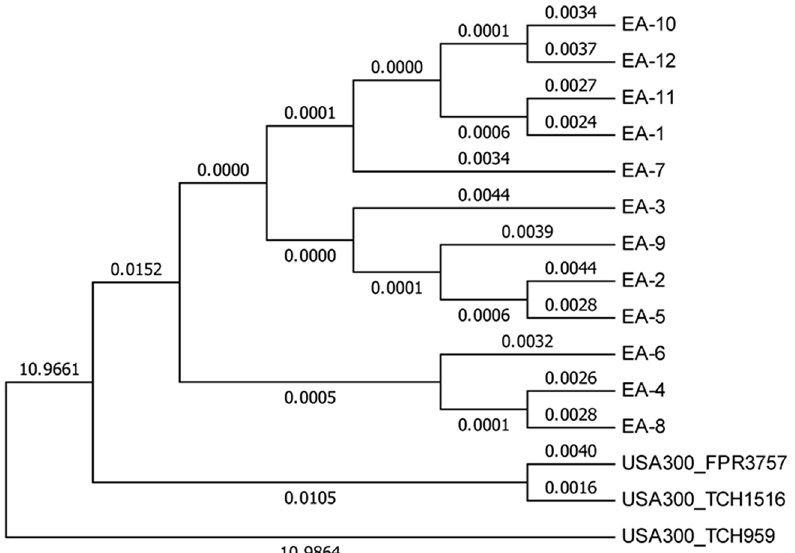
Fig 3. Dendrogram of the phylogenetic analysis by maximum likelihood (PAML) comparing study isolates (EA-1 through EA-12) with reference strains (FPR3757; TCH1516; and TCH959). The evolutionary distances between sequences is indicated by computing the proportion of nucleotide differences between each pair of